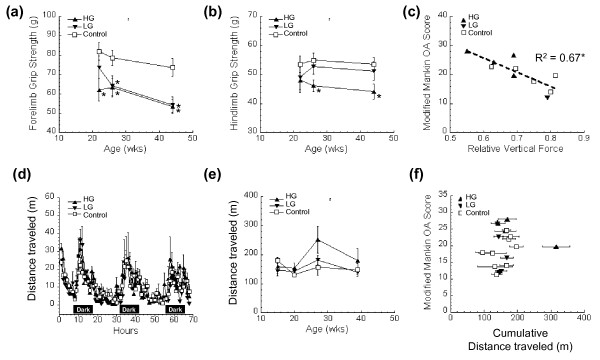
Musculoskeletal performance in high-fat-fed mice. (a) Fore-limb grip strength reductions in high-fat (HF)-fed mice over time (three measurements/animal/timepoint). (b) Hind limb grip strength reductions in HF-fed high gainer (HG) mice over time (three measurements/animal/timepoint). (c) Knee joint osteoarthritis (OA) scores were negatively correlated with the peak vertical component of the ground reaction force (expressed per unit body mass) from the hind limb during self-selected steady-speed locomotion. (d) Spontaneous horizontal distance traveled during a 72-hour period in control and HF-fed mice at 39 weeks of age. (e) Average horizontal distance traveled during a 10-hour dark period by control and HF-fed mice at different ages. (f) Comparison of knee OA score with the cumulative dark phase distance traveled (average of 15, 20, 27, and 39 weeks of age). Data shown as mean ± standard error of the mean. *P < 0.05 versus age-matched controls.